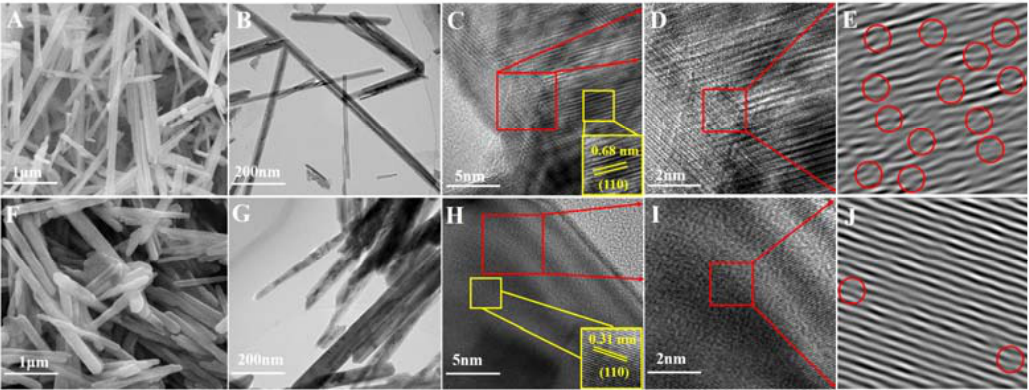
Figure 2. SEM, TEM and HRTEM images of α -MnO 2 ( A – D ) and β -MnO 2 ( F – I ); The inverse FFT images for α -MnO 2 ( E ) and β -MnO 2 ( J ).